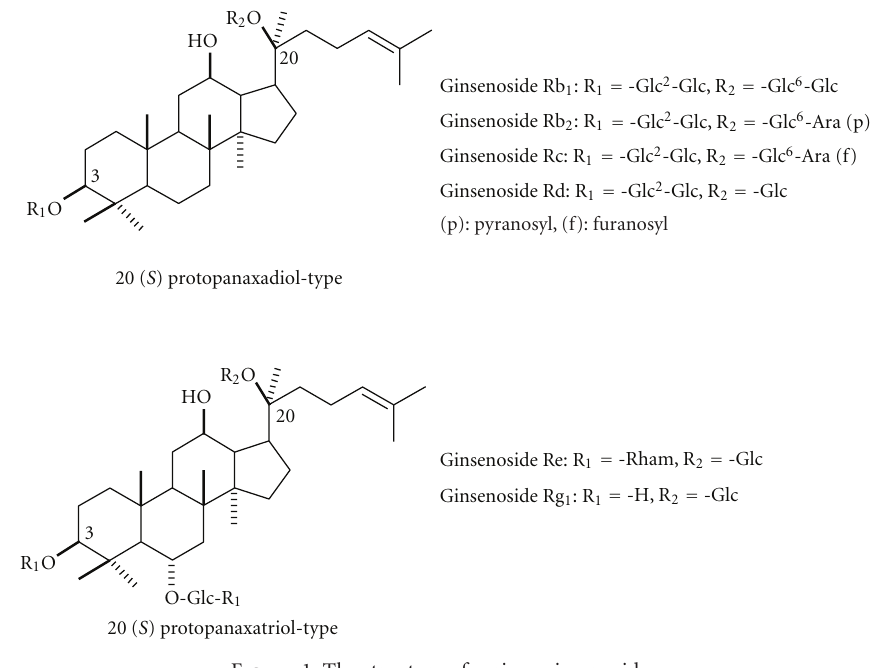
Figure 1: The structure of various ginsenosides.